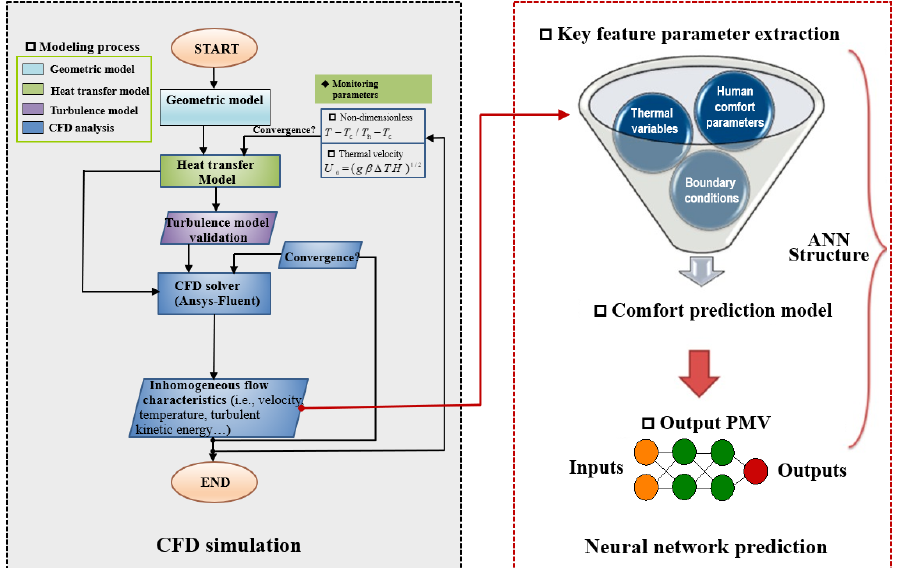
Figure 1. Schematic of the modeling process.